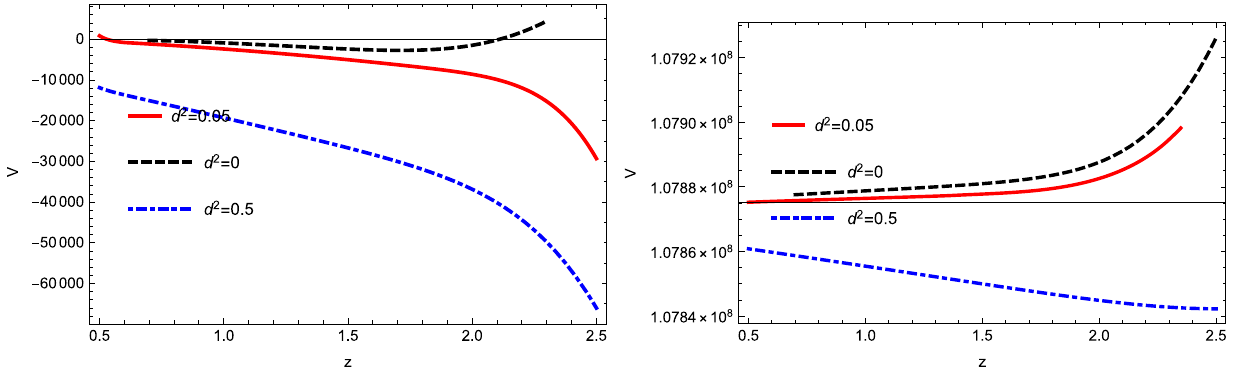
Fig. 6 Plot of V verses z for u = 1 and u = 2 . 002 for quintessence scalar field